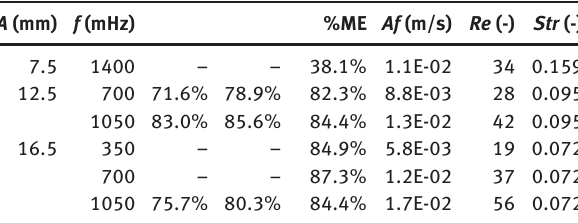
Table 1 Different amplitudes and frequency tested at 27 ° C for three different residence times (3.7, 7.3 and 9.8 min).